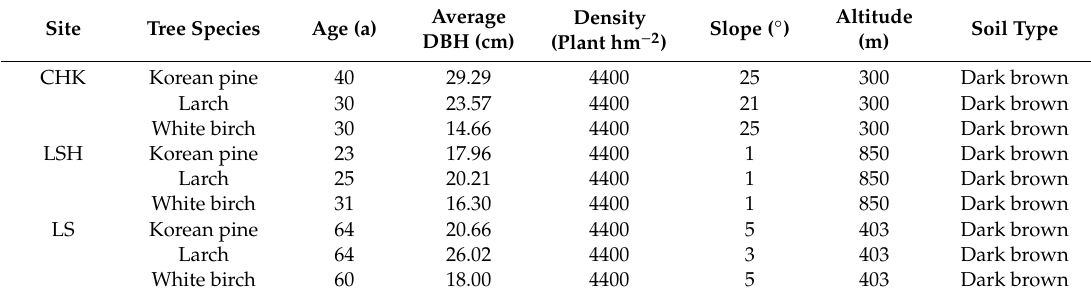
Table 2. Stand characteristics of three plantations in three